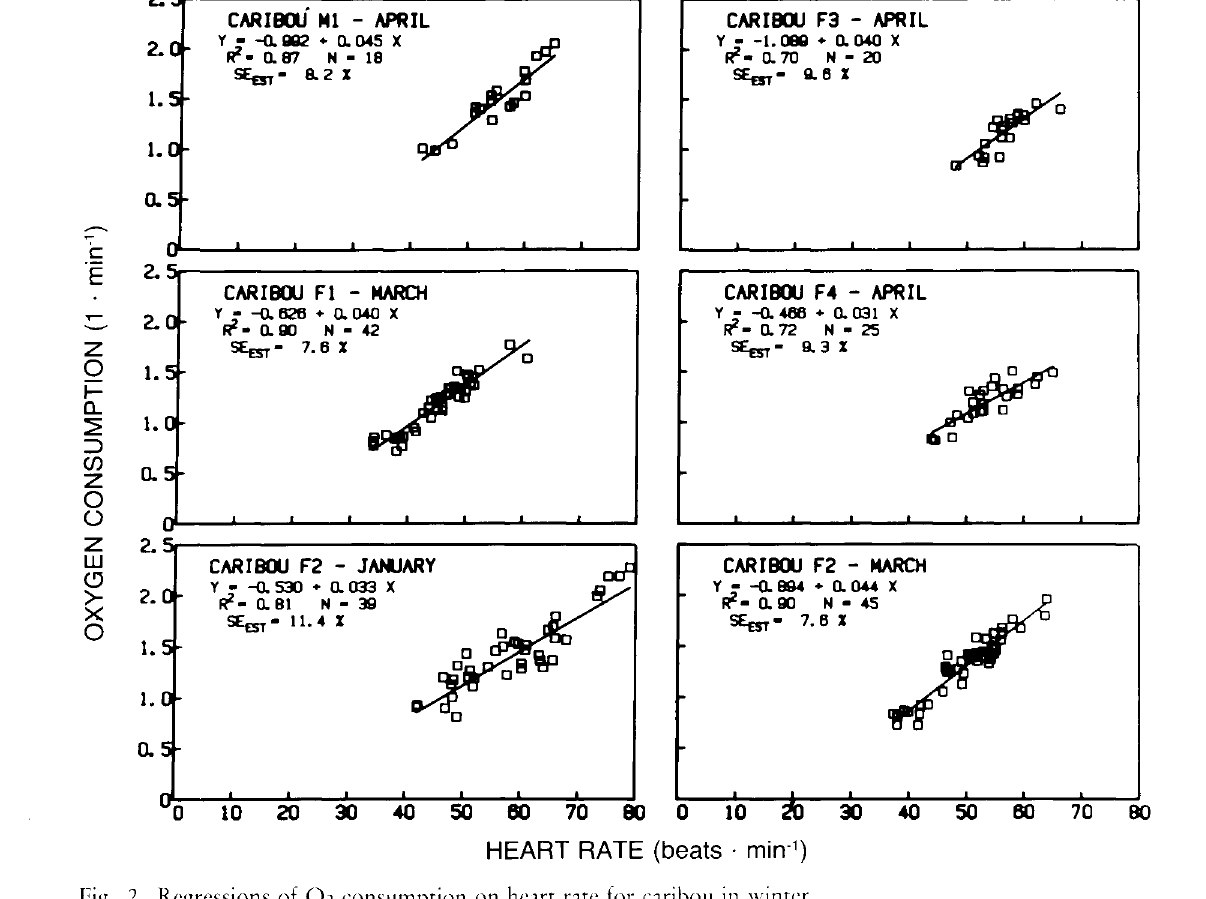
Fig. 2. Regressions of O2 consumption on heart rate for caribou in winter. they ranged within the 19-ha enclosure.